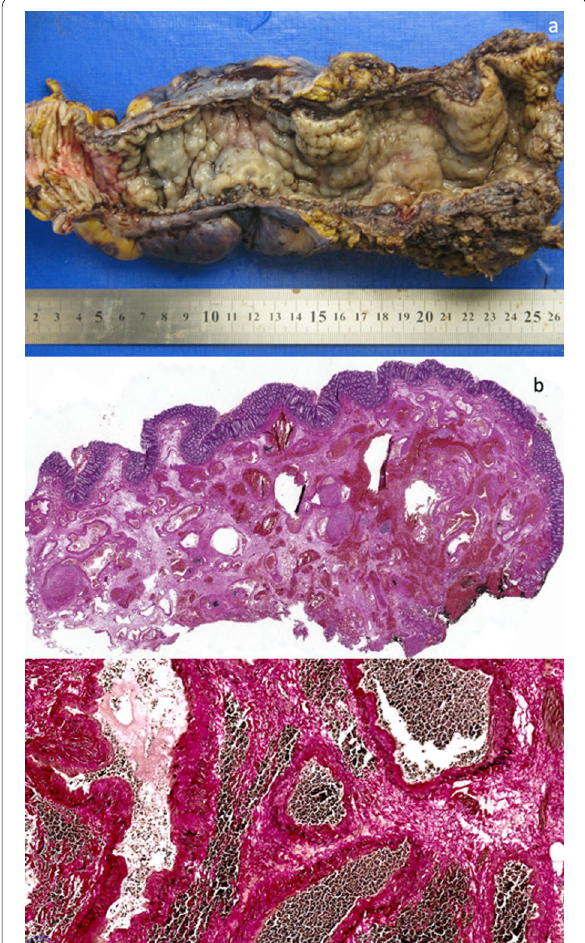
Fig. 4 The macroscopic ( a ) and microscopic ( b , c ) specimen images. Macroscopically, the appearance of the bowel mucosa resembles extensive varices. The bluish submucosal tortuous dilation of blood vessels occupies the rectum and distal sigmoid colon. The microscopic examination shows numerous disorganized, dilated, and irregularly thickened abnormal blood vessels. There is a combination of new and organized-calcified thrombi. The vessels have a conspicuous muscular layer formed by the arterial type and venous type elastic